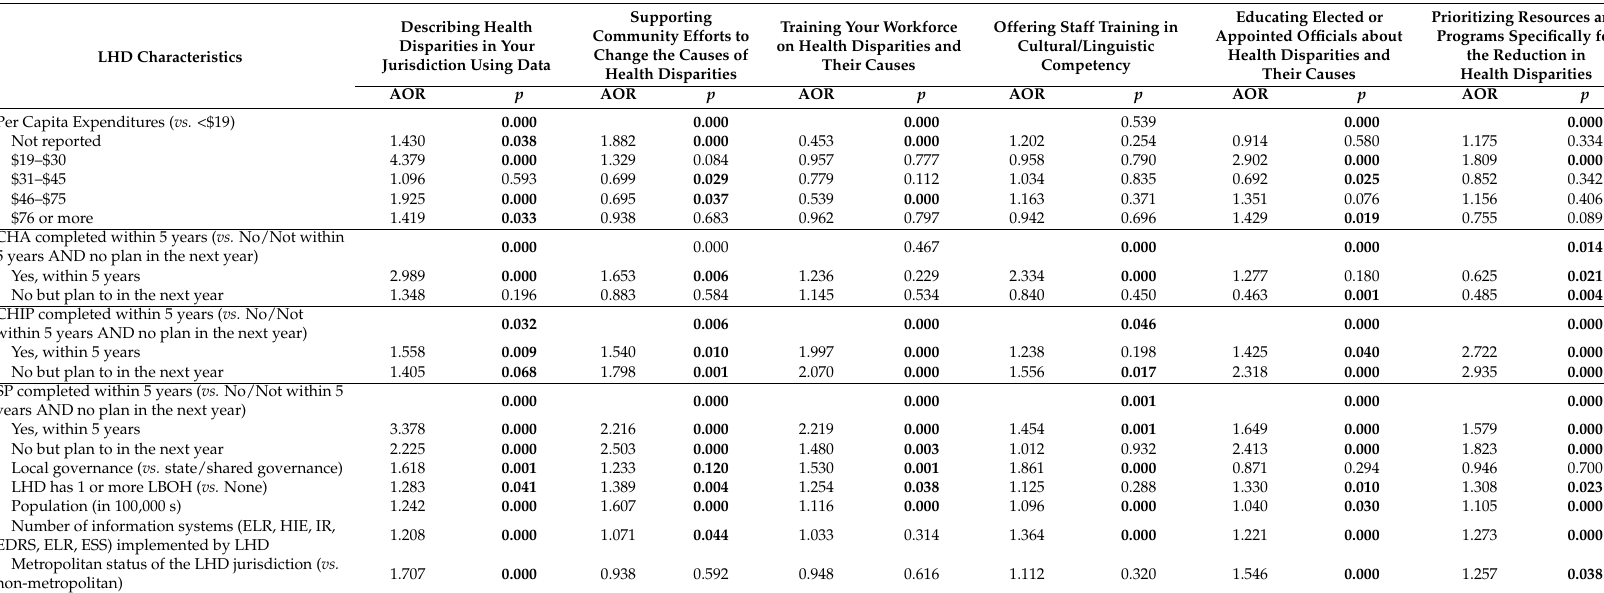
Table 3. Logistic regression of activity performed by LHDs in the past two years to address health disparities, defined as differences in health status that occur among population